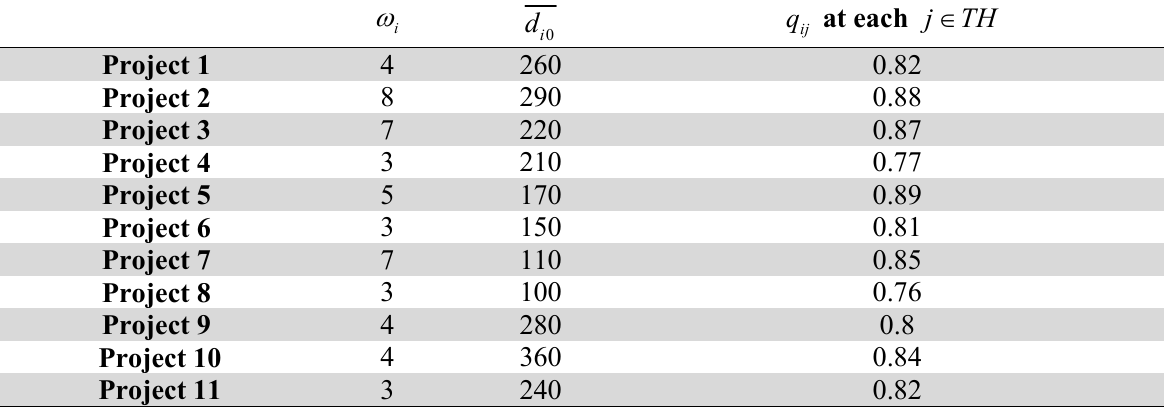
The cost of different